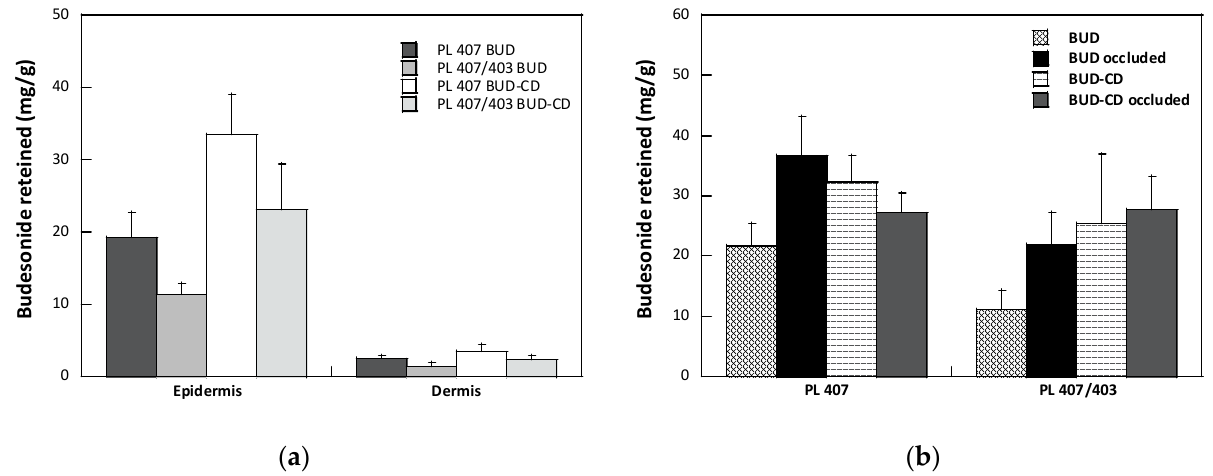
Figure 3. ( a ) Effect of formulation on BUD retention in the epidermis and dermis (mean value ± sem); ( b ) Effect of occlusion on the total amount of BUD recovered from the skin (mean value ± sem). For all formulations tested, the amount of BUD recovered in the receptor compartment was under the lower limit of quantification of the analytical method (0.05 µ g/mL [34]), suggesting that the potential systemic absorption was avoided. As reported in Figure 3a, BUD accumulated preferentially in the epidermis compared to the dermis. The higher